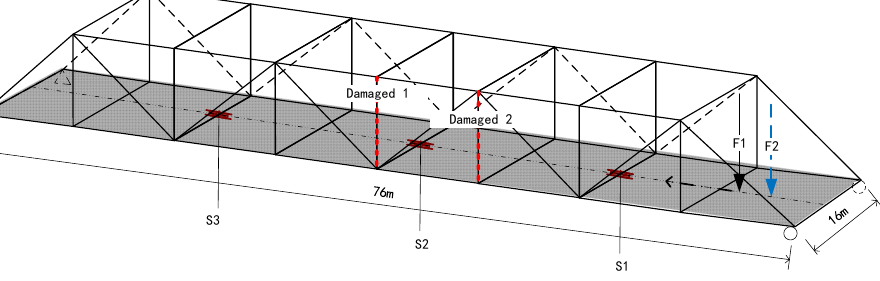
Figure 5. A simply supported truss beam under moving load.